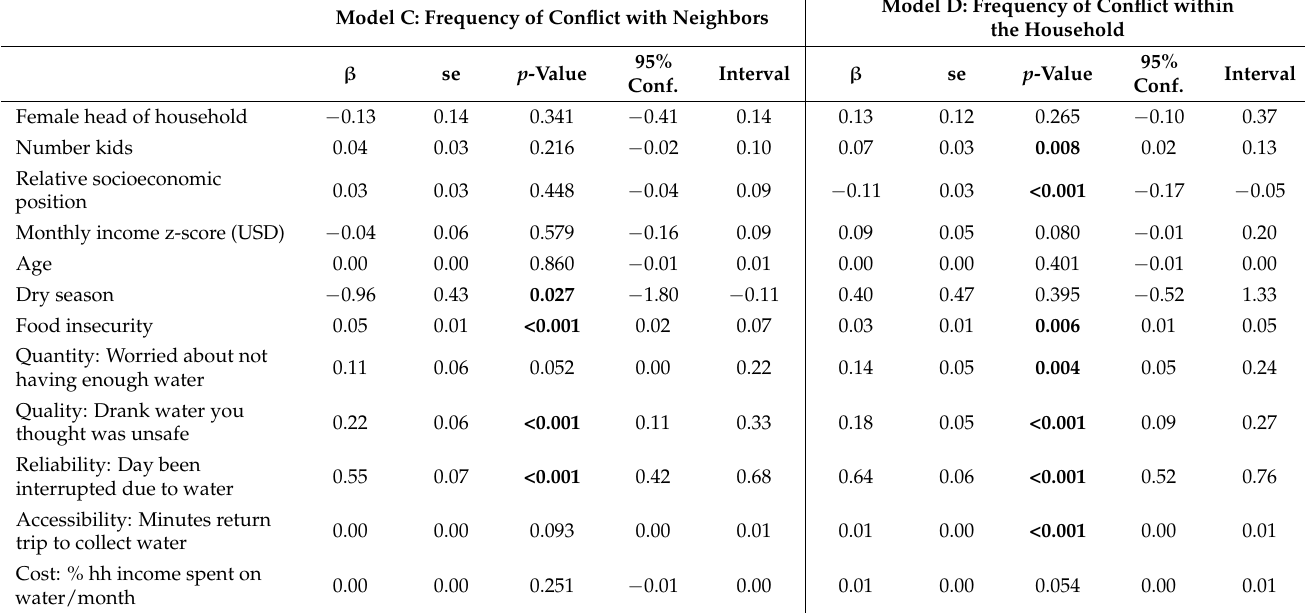
Table 5. Ordinal logistic regression modeling results for associations between demographic characteristics, water insecurity domains, and conflict with neighbors (Model C) or within the household (Model